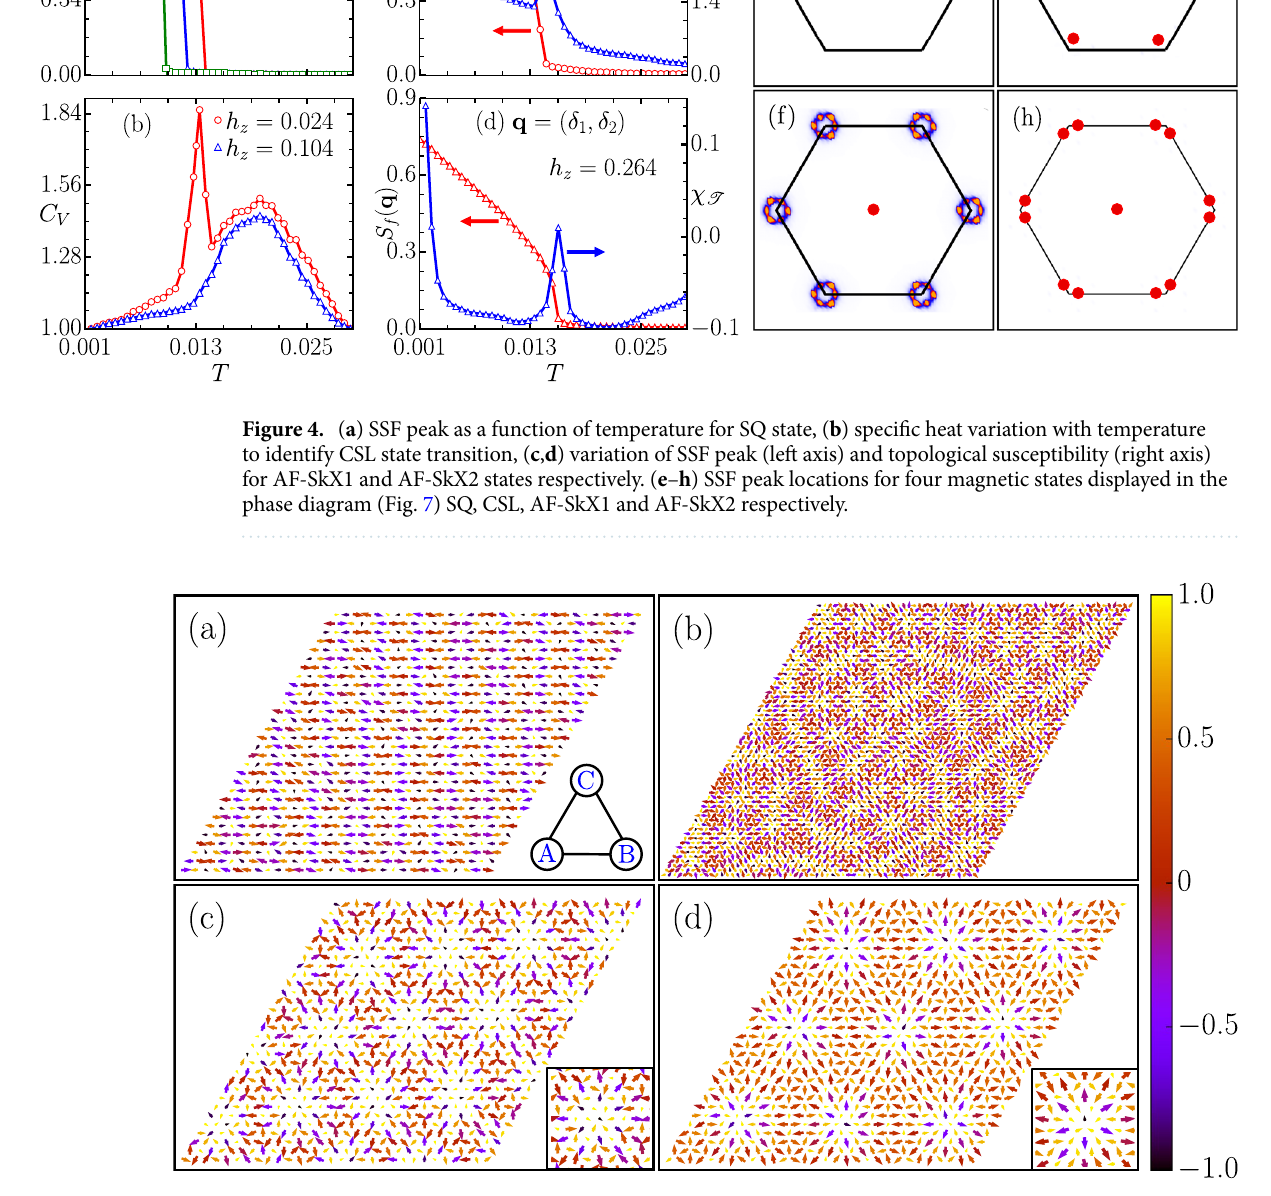
Figure 5. Low-temperature spin configurations for ( a ) single-Q spiral, ( b ) classical spin liquid, ( c ) AF-SkX1 and ( d ) AF-SkX2 states. The z -component is represented by the color bar and the planar components by the 30 section of the simulated lattice in panels ( a ), arrow lengths and directions. For clarity, we only display a 30 × 60 for ( b ). The insets in ( c ) and ( d ) show the zoomed-in view of spins in the core of skyrmions. ( c ), ( d ) and 60 × The inset of ( a ) denotes the three-sublattices (A, B, C) in a single triangular